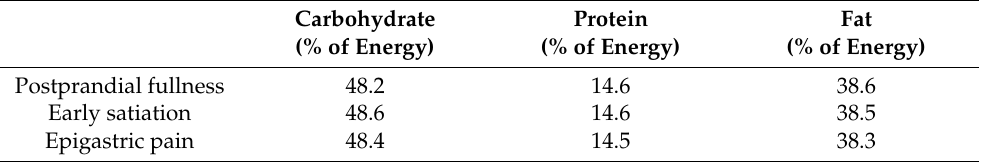
Table 7. Calculated macronutrient intakes to prevent symptoms of uninvestigated dyspepsia in individuals with the